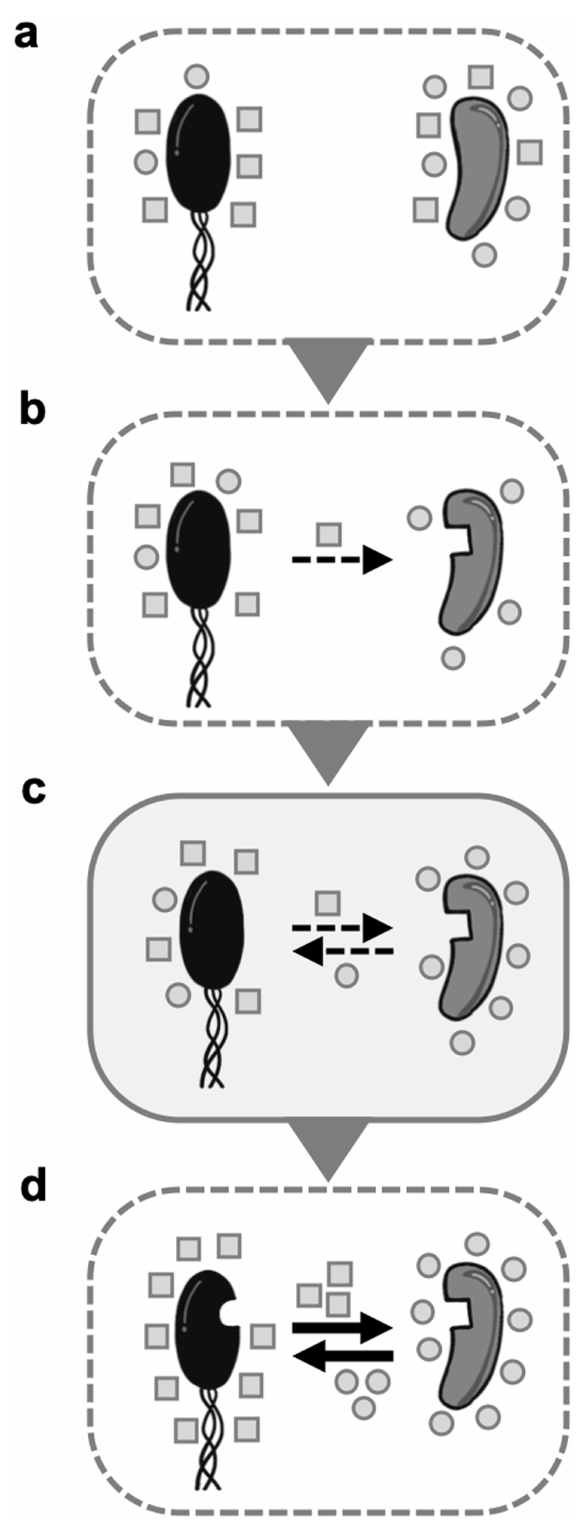
Fig. 1 Conceptual model for the emergence of cooperative cross- feeding interactions. a Metabolic autonomy: prototrophic donor cells grow autonomously and release metabolites (grey circles and squares) into the extracellular environment. b Unidirectional bypro- duct cross-feeding: auxotrophic mutants arise that have lost the ability to autonomously produce one metabolite that is produced by the other cell. By consuming it, a unidirectional cross-feeding interaction between a prototrophic donor and an auxotrophic recipient is established. c Bidirectional byproduct cross-feeding: reciprocity emerges between both interaction partners when the prototrophic donor also starts to bene fi t from the presence of the auxotrophic recipient. d Bidirectional cooperative cross-feeding: a cooperative interaction evolves when both parties start to actively invest costly resources to bene fi t their corresponding partner. Grey area ( c ) = critical step during the evolution of cooperative cross- feeding, which is the focus of this study. Dashed arrows indicate an exchange of metabolic by-products and solid arrows denote cooperative metabolic interactions. Figure modi fi ed after